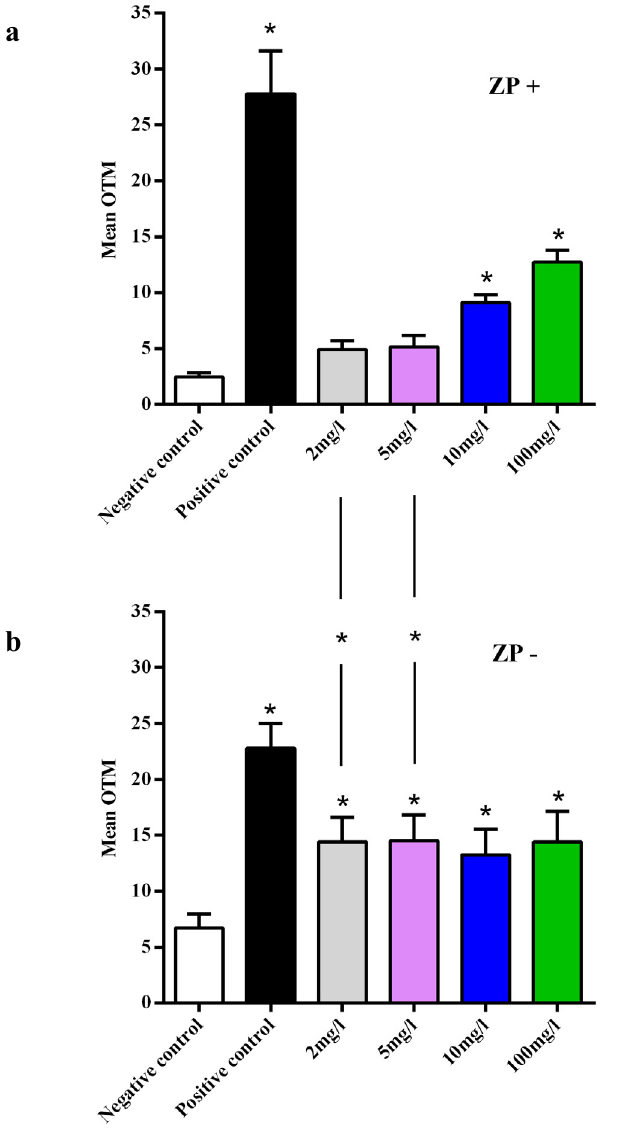
Figure 4. Genotoxicity assessment of C ( a ) Oocytes surrounded by zona pellucida (ZP+); ( b ) Oocytes not surrounded by zona pellucida (ZP − ). * p ≤